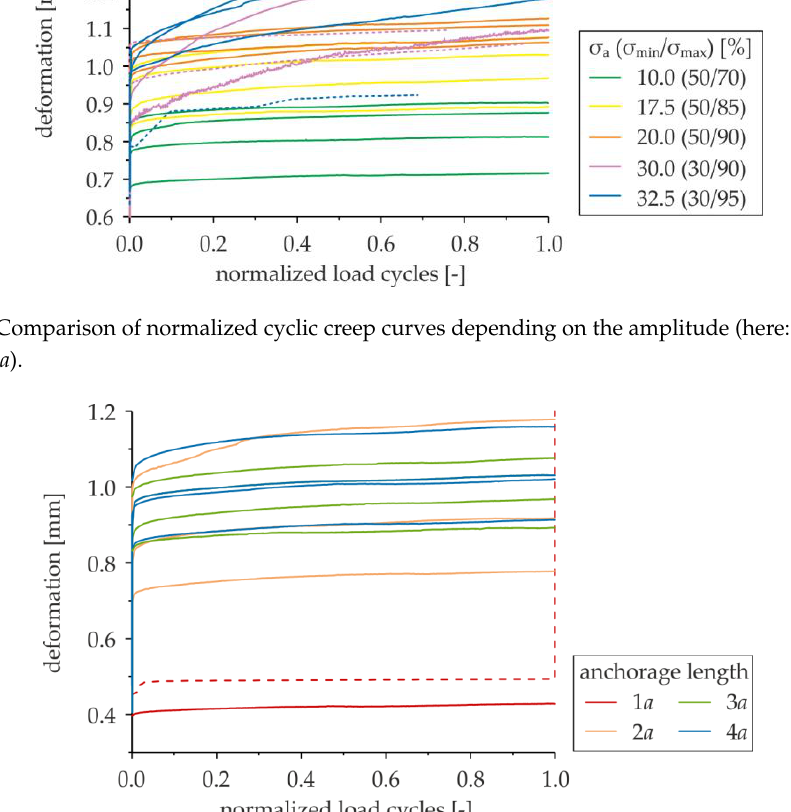
Figure 9. Comparison of normalized cyclic creep curves of different anchorage lengths at similar load level (here: σ min / σ max = 50%/85%).